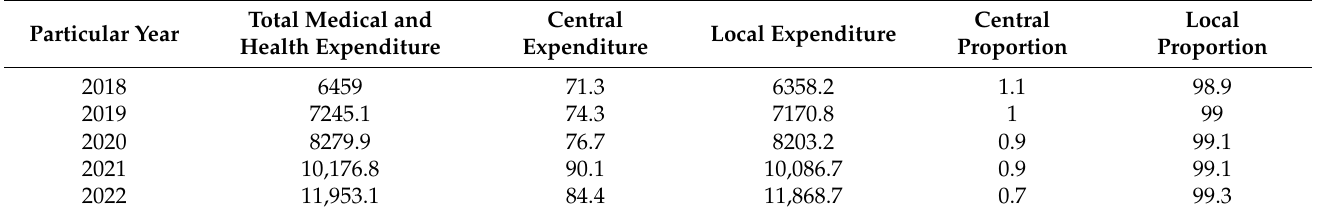
Table 6. Structure of government expenditure on health care in China from 2013 to 2022 unit: CNY 100 million,